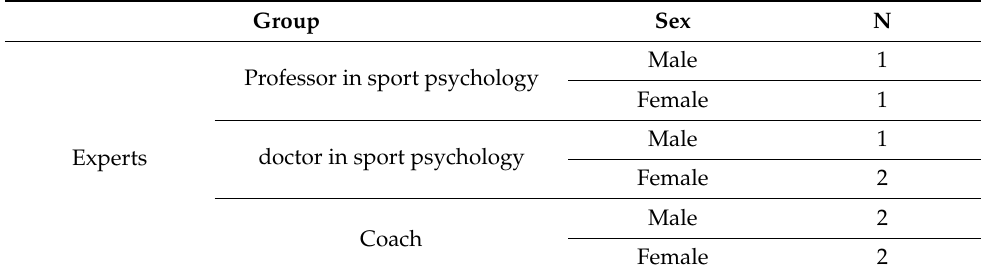
Table 1. General characteristics of the expert group.